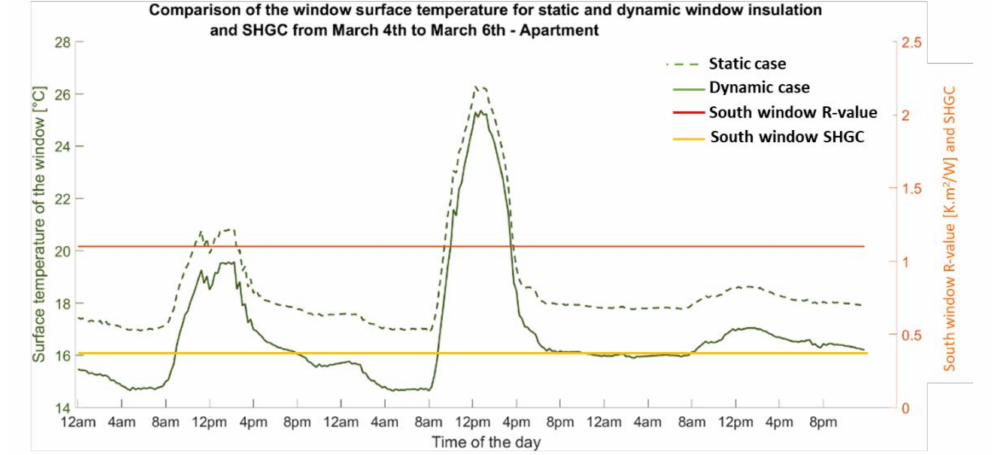
Figure 8. Interior surface temperature of the south wall for static and dynamic window dur- ing 4 March to 6 March for the prototypical apartment unit. For dynamic windows, high R-value = 1.1 m 2 · K/W; low R-value = 0.45 m 2 · K/W; high SHGC = 0.4; low SHGC = 0.1. For static windows, R-value = 0.45 m 2 · K/W; SHGC =